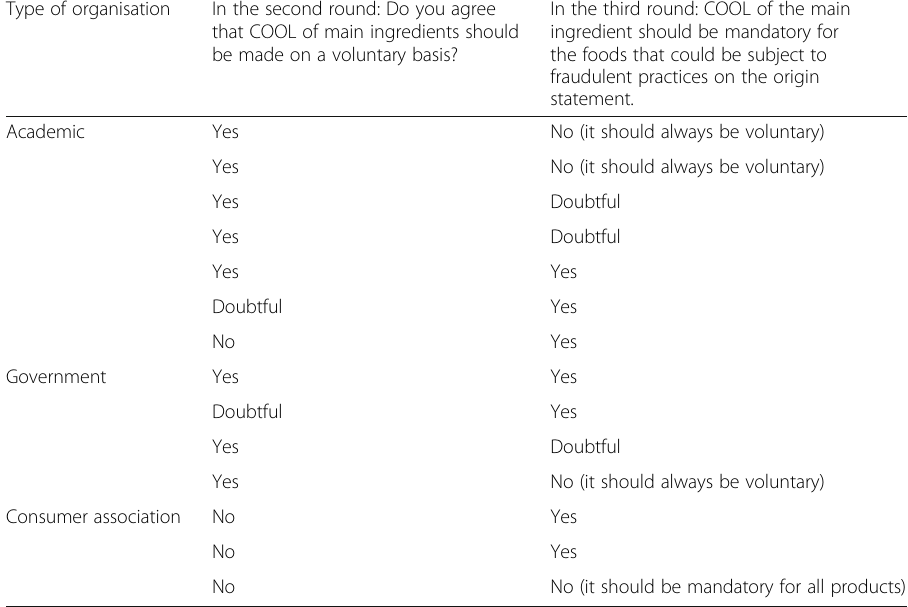
Table 2 Comparison of the answers between the second round and third round Type of